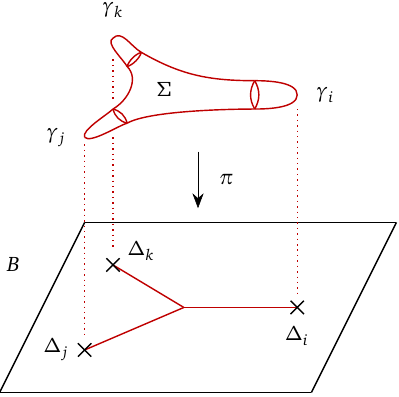
Figure 5: Picture of a compact 2-cycle Σ connecting to multiple components of the ramification locus and projecting to a